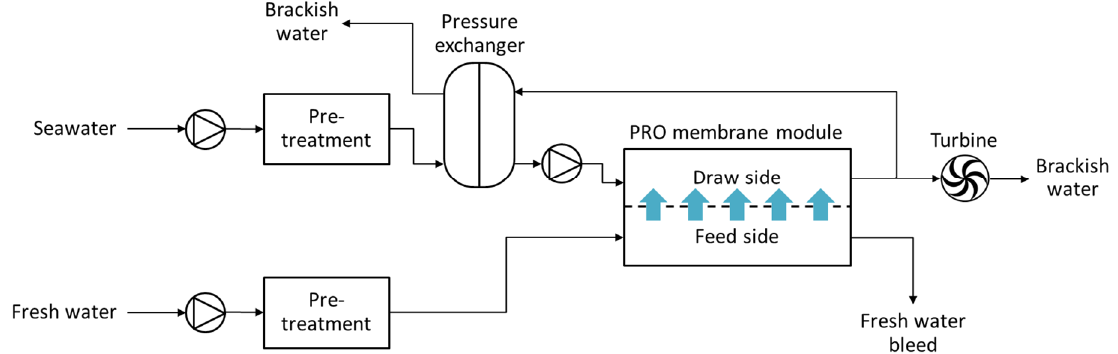
Figure 4. Schematic of Statkraft’s PRO pilot plant, adapted from